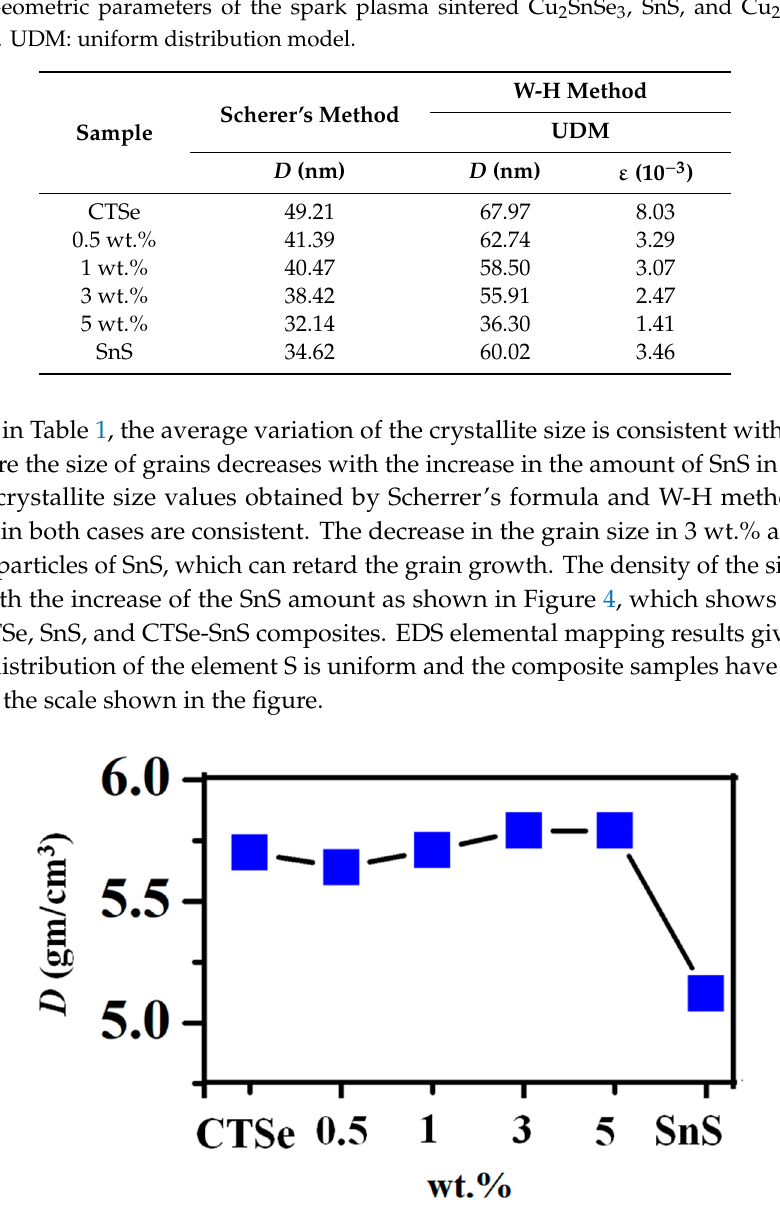
Figure 5. Energy dispersive spectroscopy (EDS) mapping images of the CTSe and SnS composites. The analyses were performed on the polished surfaces of the pellets.